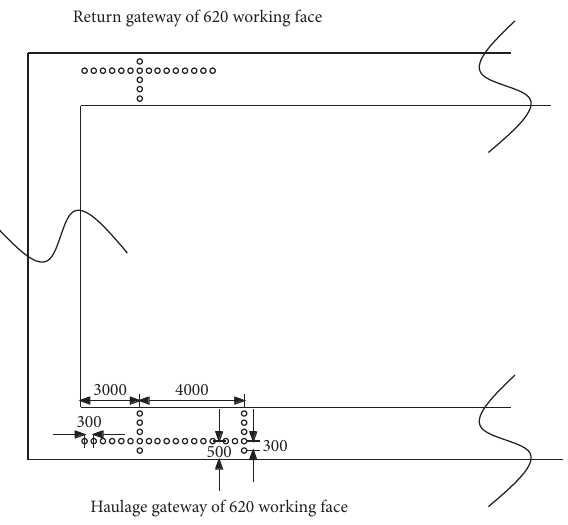
Figure 8: Caving hole layout parameters.